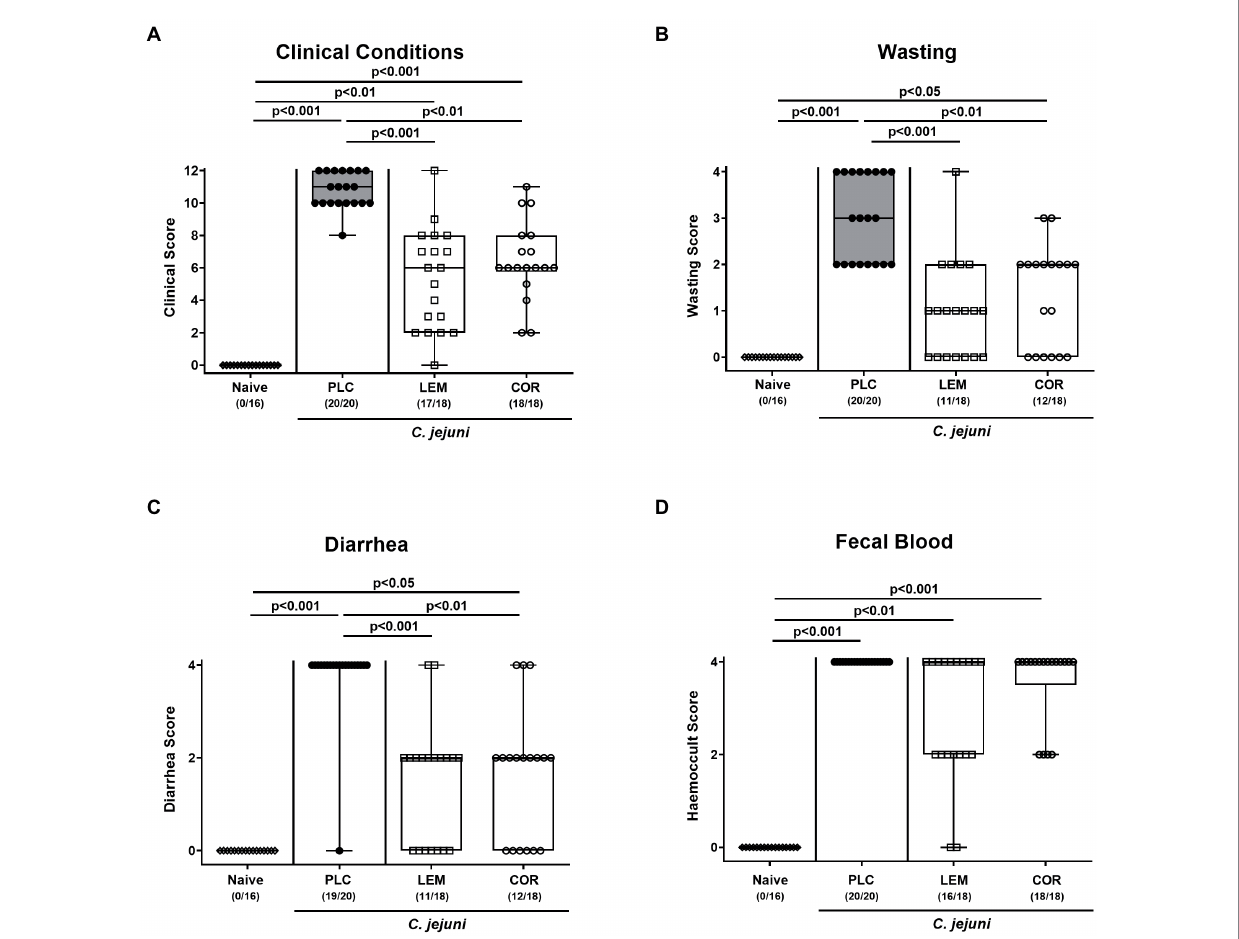
FIGURE 2 Clinical outcome following prophylactic oral application of lemon or coriander essential oil to C. jejuni infected mice. SAB IL-10 − / − mice were subjected to prophylactic lemon (LEM; white squares) or coriander (COR; white circles) essential oil via the drinking water ( ad libitum ) starting seven days prior infection. Placebo (PLC; black circles) control animals received tap water only. On days 0 and 1, mice were then perorally infected with C. jejuni strain 81–176 by gavage. (A) The overall clinical conditions of mice were quantitatively surveyed on day 6 post-infection by using a cumulative clinical scoring system